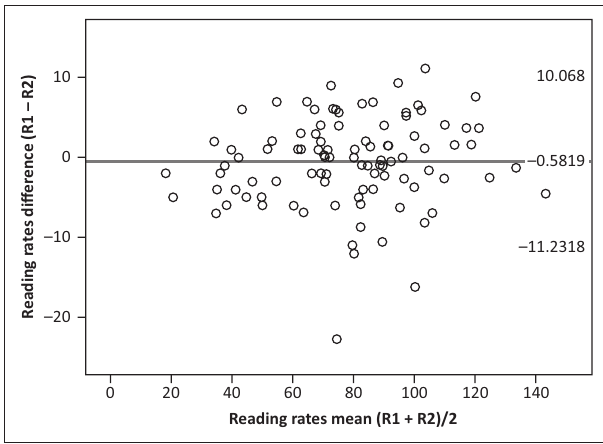
FIGURE 5: Differences between reading rate (correct words per minute) test (R1) and retest (R2) for individual learners ( N = 100) obtained with paediatric rate of reading (PRR) chart are plotted against the averages of R1 and R2 reading rates, 1 week apart, according to the Bland and Altman method. The derived 95 % confidence intervals are also shown (dotted lines). The mean test–retest difference is very small (−0.58) and is indicated by a solid black line.